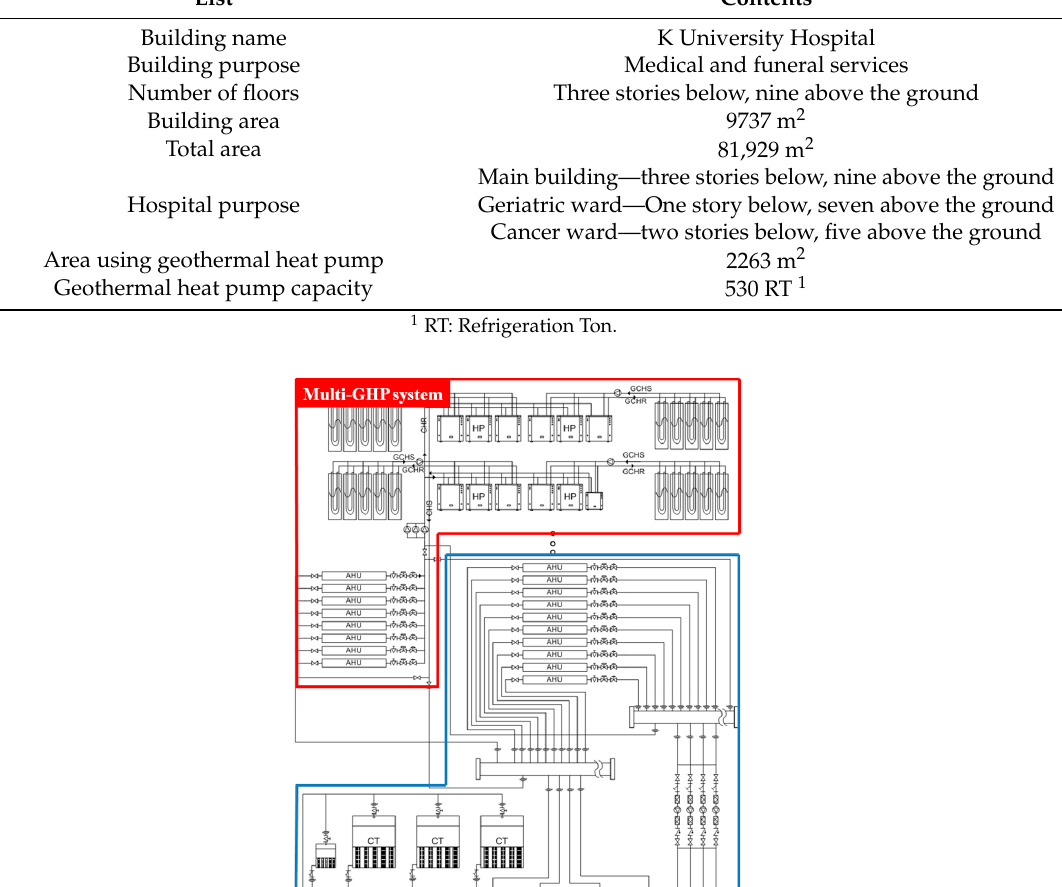
Table 4. Summary of the building information.